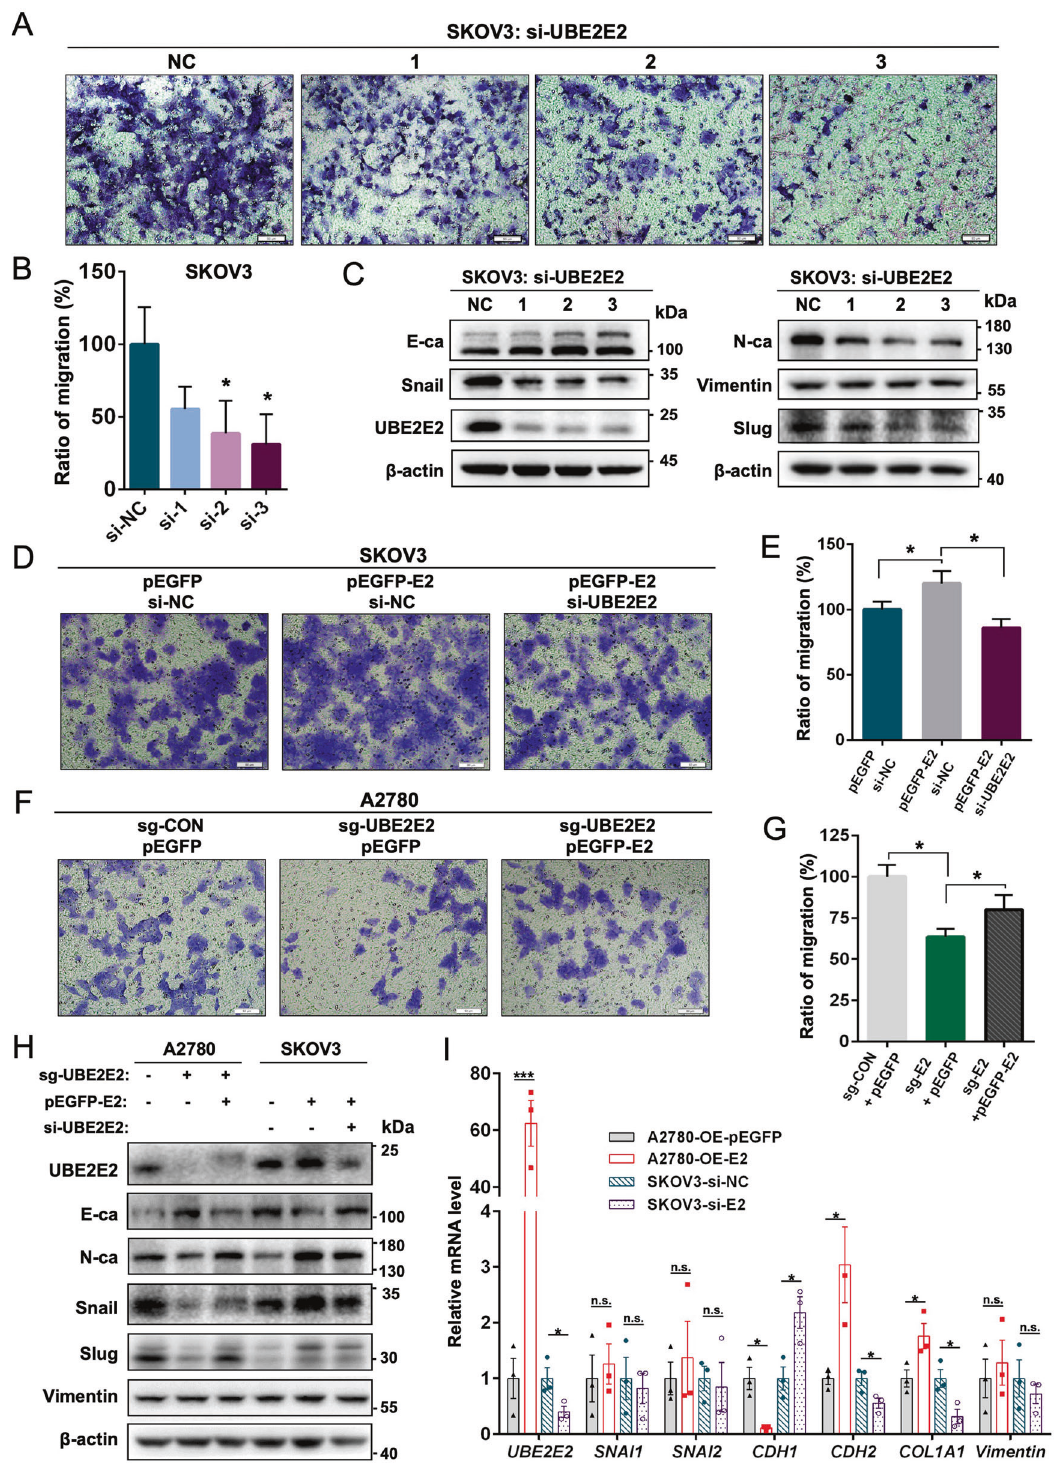
Fig. 3 UBE2E2 induces EMT in OvCa cells. A Representativeimagesof SKOV3cellmigration after transfection with negative control(NC)siRNAor UBE2E2siRNA(scalebar = 50 μ m). B Themigrationratiowascalculatedbydividing theaveragenumberofmigratedcellsinthe UBE2E2siRNAgroup bythe averagenumber of migrated cellsinthe NC group (* p < 0.05versus NC). C Westernblot analysis of EMTmarkersin SKOV3cells wasperformed 72 h after siRNA transfection. D Representative images of SKOV3 cell migration. SKOV3 cells were transfected with NC or UBE2E2 siRNA 24 h after transfection withpEGFP-C1 or pEGFP-C1-UBE2E2 plasmids (scale bar = 50 μ m). E The migration ratio wascalculated bydividingthe averagenumber of migrated cells in the treated group compared with the control group. F Representative images of A2780 cell migration after transfection with pEGFP-C1 or pEGFP-C1-UBE2E2 plasmids (scalebar = 50 μ m). G The migration ratio was calculatedby dividing the averagenumber of migrated cells in the treated group compared with the control group. H Western blot analysis of EMTmarkers in OvCa cells. I qRT – PCR analysis of UBE2E2 and EMT markers in OvCa cells ( n = 3, * p < 0.05, *** p < 0.005). n.s. no signi fi cant differences detected, OE overexpression, E2 UBE2E2.